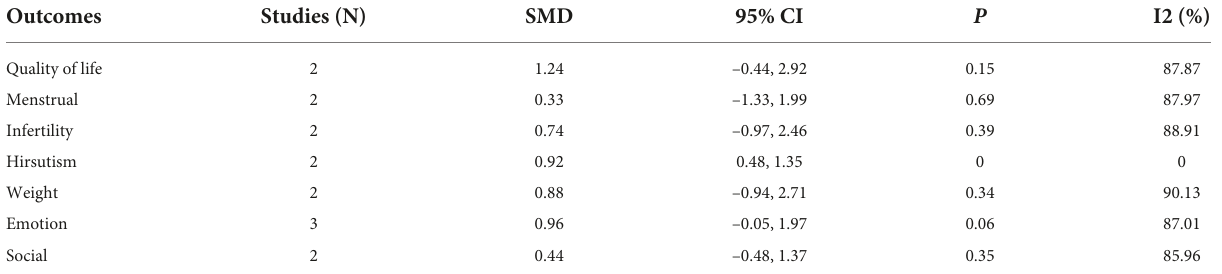
FIGURE4 Meta-analysis of BMI.